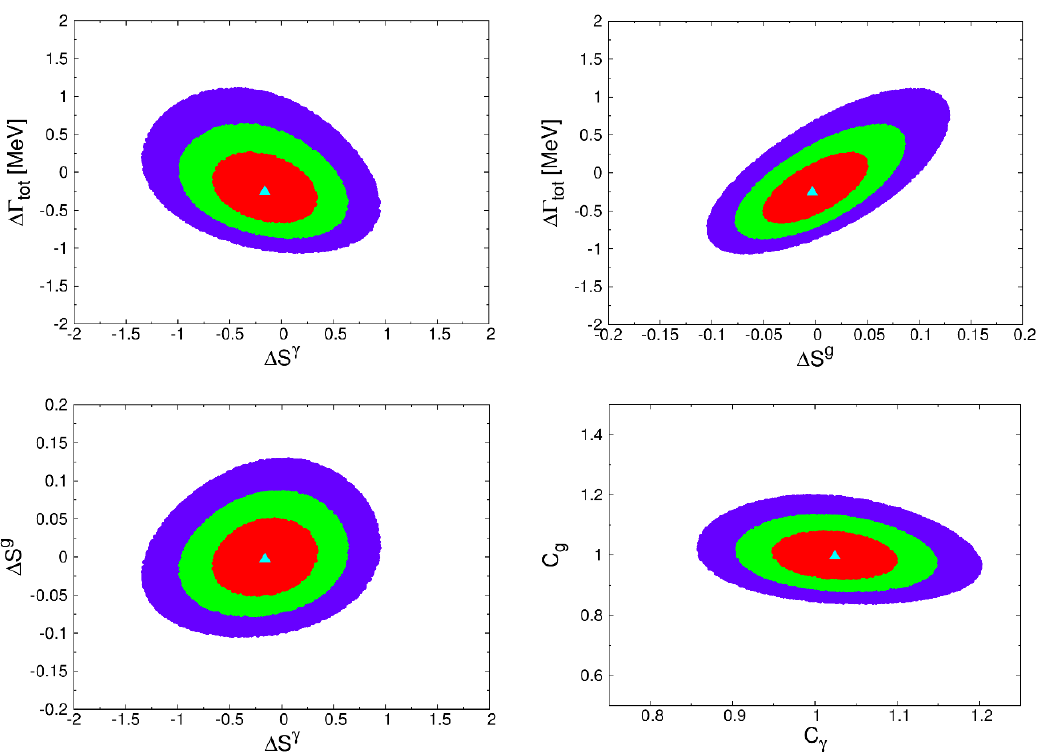
Figure 3 . CPC3 : the con(cid:12)dence-level regions of the (cid:12)t by varying (cid:1) S (cid:13) , (cid:1) S g , and (cid:1)(cid:0) tot . The color code is the same as in (cid:12)gure 2.